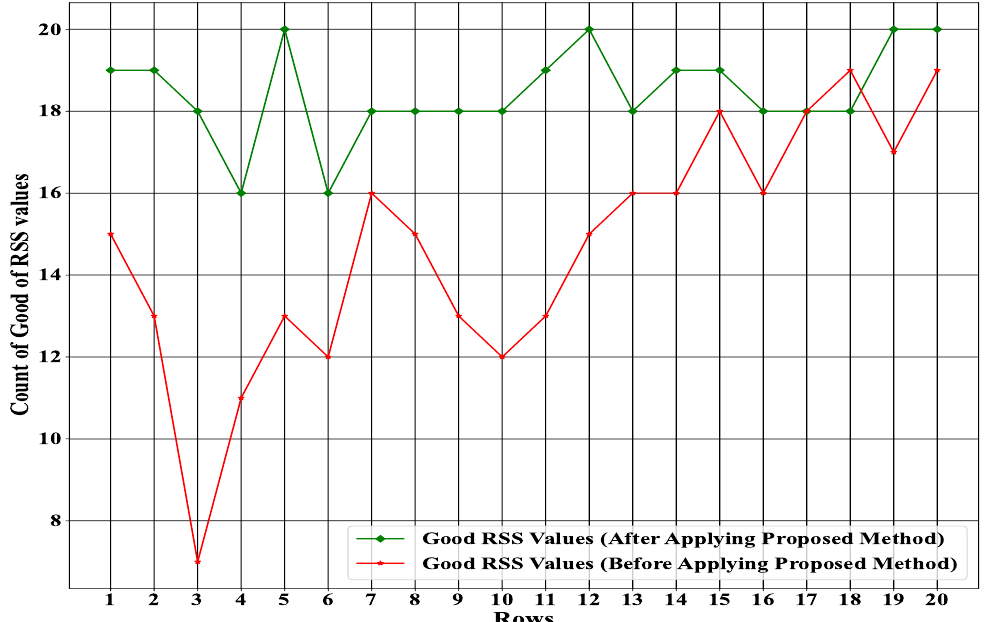
Figure 10. Improving the number of good RSS values before and after applying the proposed